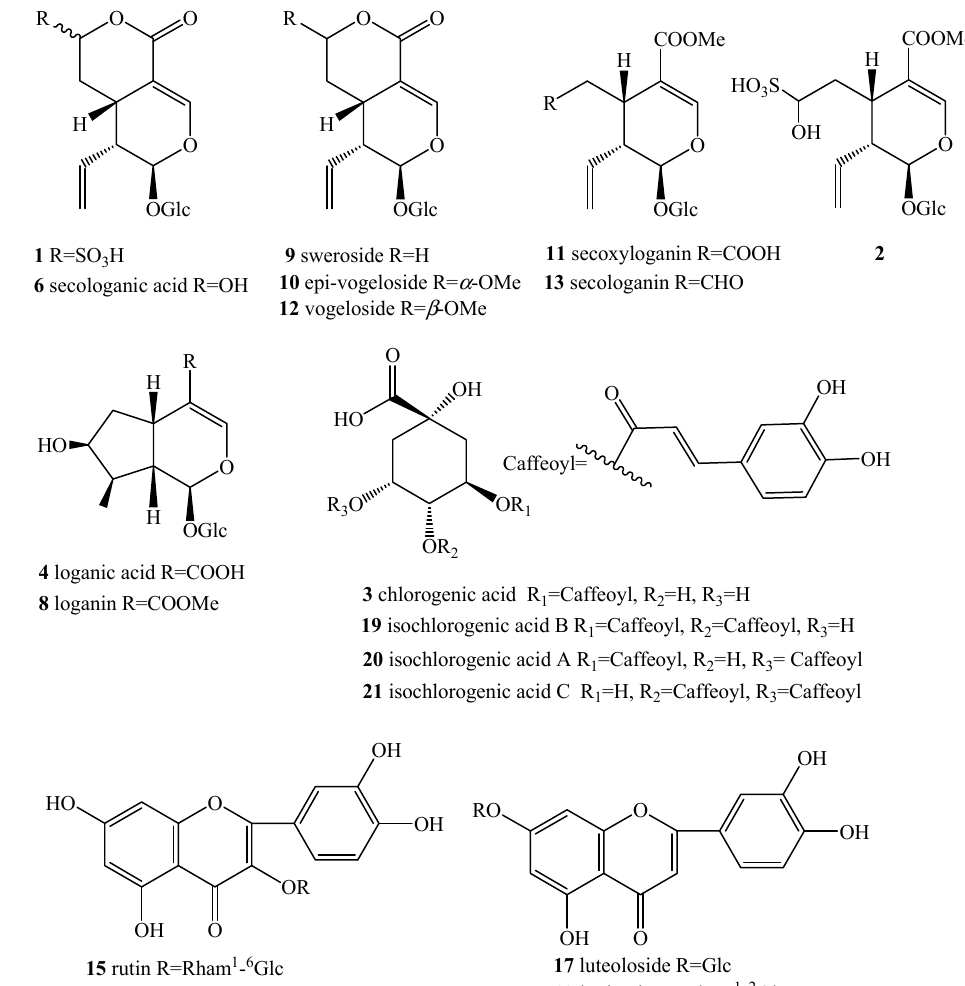
Figure 2. Chemical structures of the main compounds in LJF